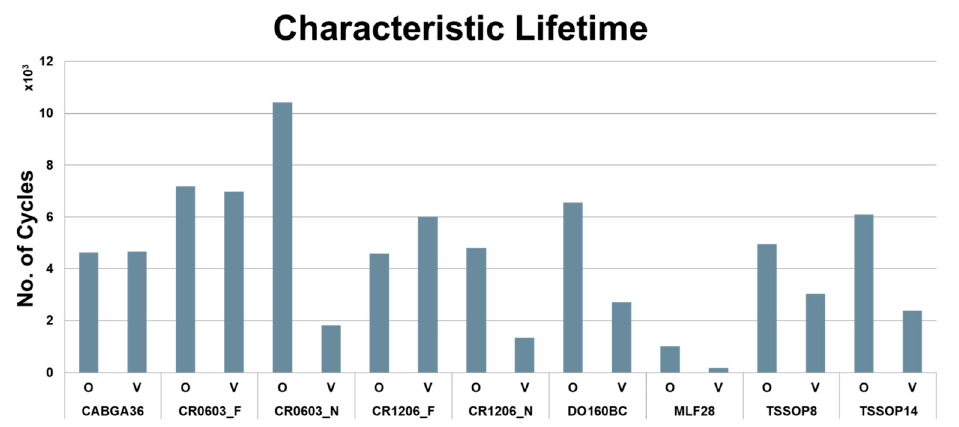
Figure 11. Histogram showing the deduced characteristic lifetime values for all the combinations. The component nomenclature is defined in Table 1.